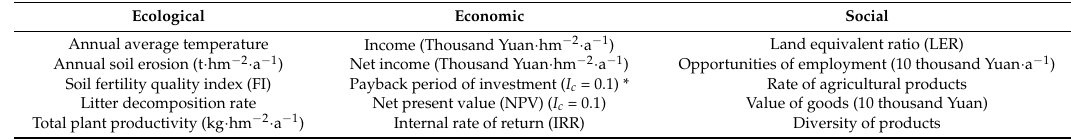
Table 1. Selected indicators for assessing and comparing different Ginkgo agroforestry